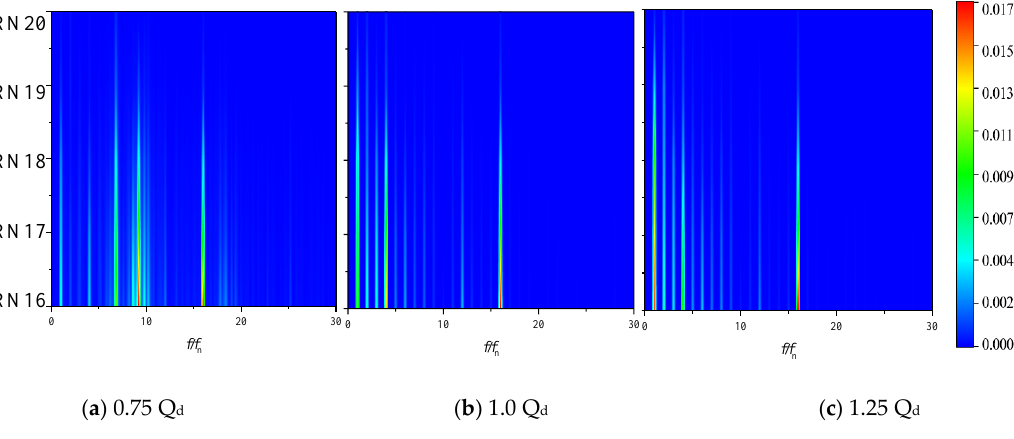
Figure 10. Frequency domain of pressure fluctuation near the pressure side of the short blade.